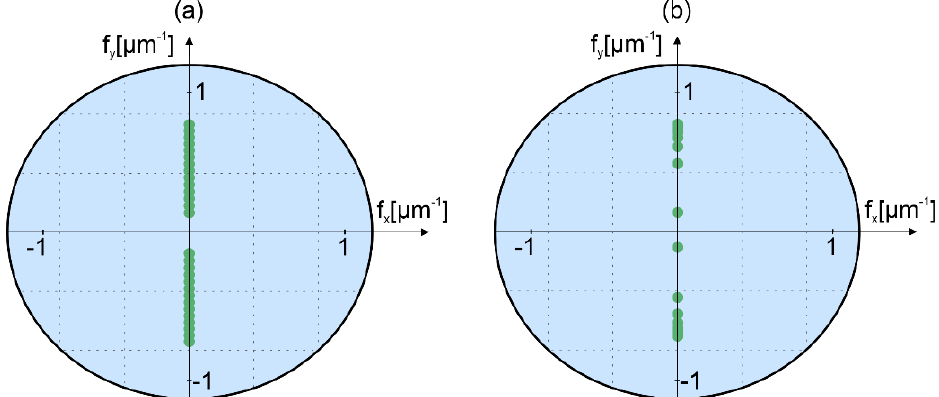
Figure 3. Frequency distribution of illumination beams in ( a ) equally angle spaced strategy; ( b ) geometrically frequency spaced strategy. The circle shows the NA limit of the imaging system.